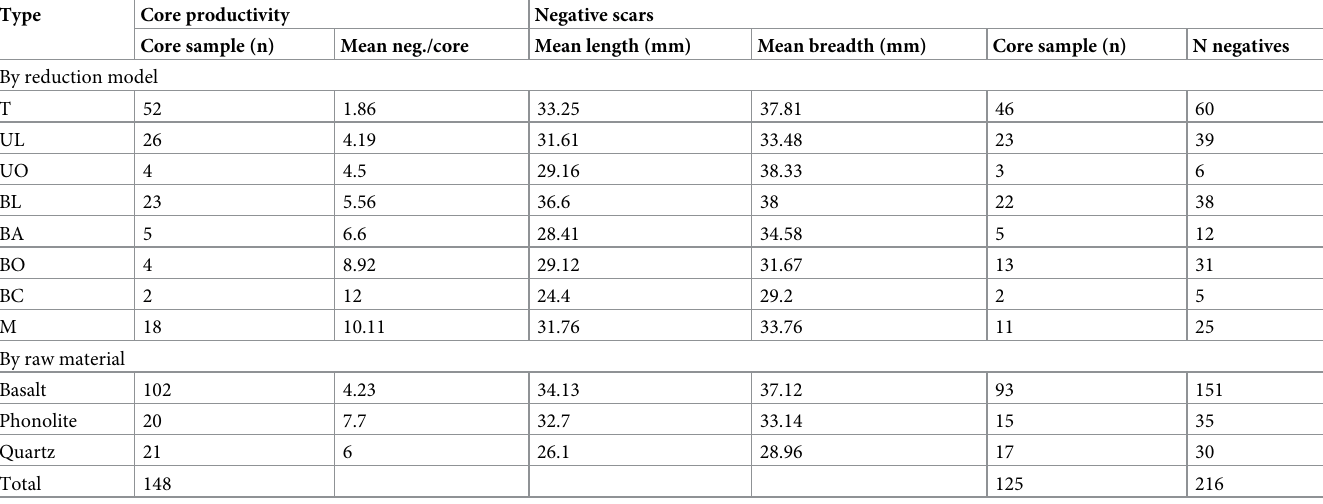
Table 3. Core productivity and mean negative scar dimensions by reduction model and raw material